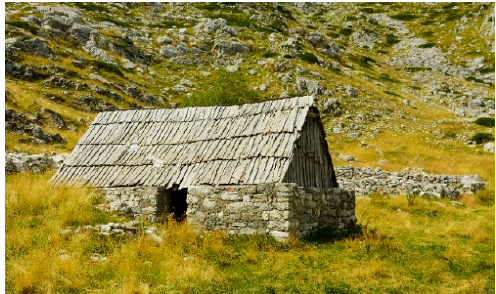
Figure 17. Gladas with its faces oriented perpendicularly to the terrain, partially dug into the ground – Koštica, Kutski katun, photo: I. Lakovi ć .